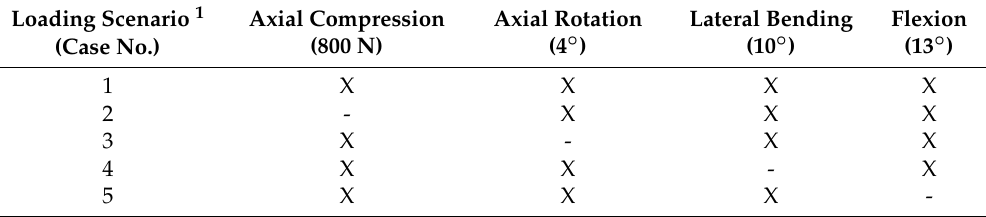
Table 2. Loading scenarios investigated in the numerical